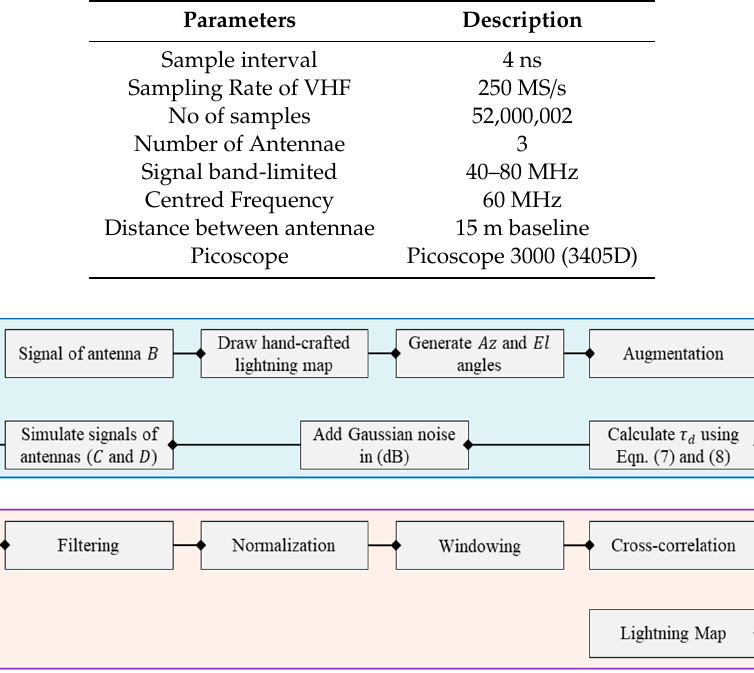
Table 1. The parameters for the interferometer and the lightning flash.